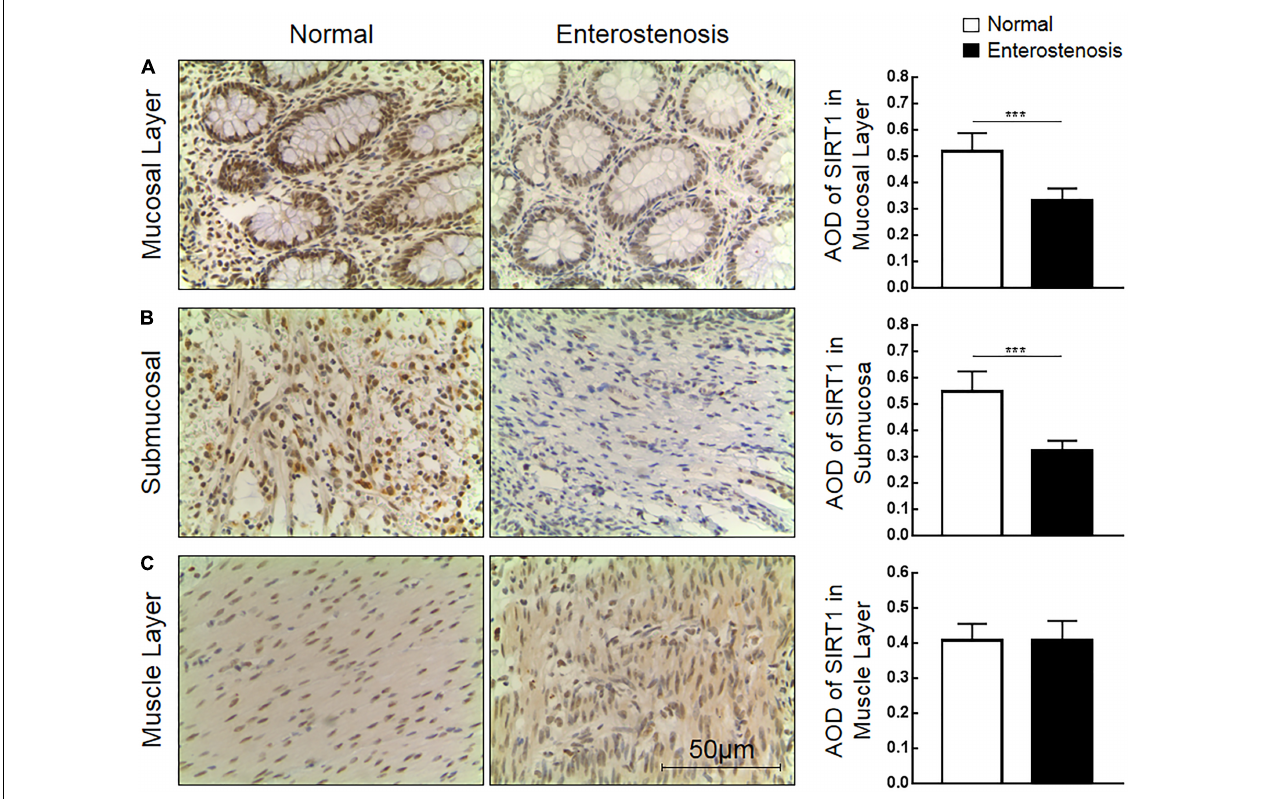
FIGURE 2 | The expression characteristics of Sirtuin1 or Silent mating–type information regulation 2 homolog-1 (SIRT1) protein in post-necrotizing enterocolitis stricture tissue. (A) Expression of SIRT1 protein in the intestinal mucosal layer. (B) Expression of SIRT1 protein in the submucosal layer of the intestine. (C) Expression of SIRT1 protein in the muscularis of the intestine. (***Denotes the enterostenosis groups compared with the normal groups, n = 43, p < 0.001). TABLE 2 | The expression of Sirtuin1 or Silent mating–type information regulation 2 homolog-1 (SIRT1) and transforming growth factor- β 1 (TGF- β 1) proteins in the two groups of intestinal tissues. Protein Anatomical structure Normal intestinal tissue ( n = 43) Narrow intestinal tissue ( n =